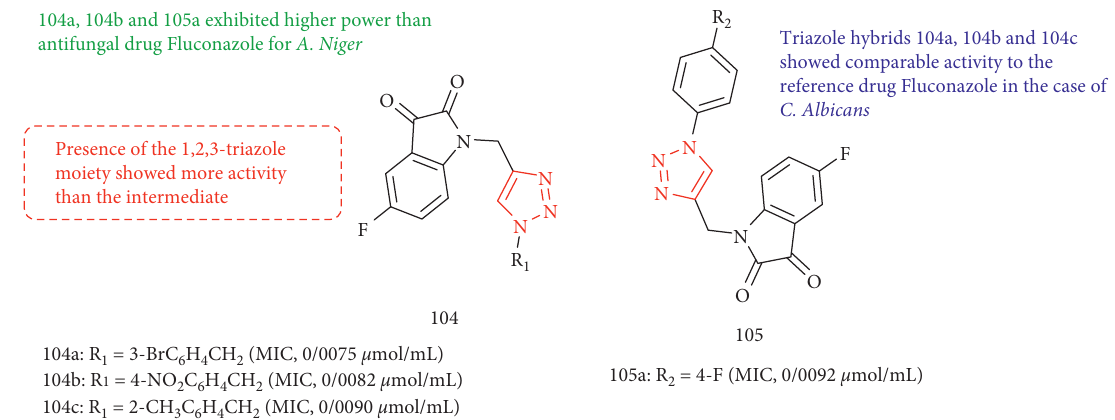
Figure 47: Chemical structure of 5-fluoroindoline-2,3-dione-triazoles